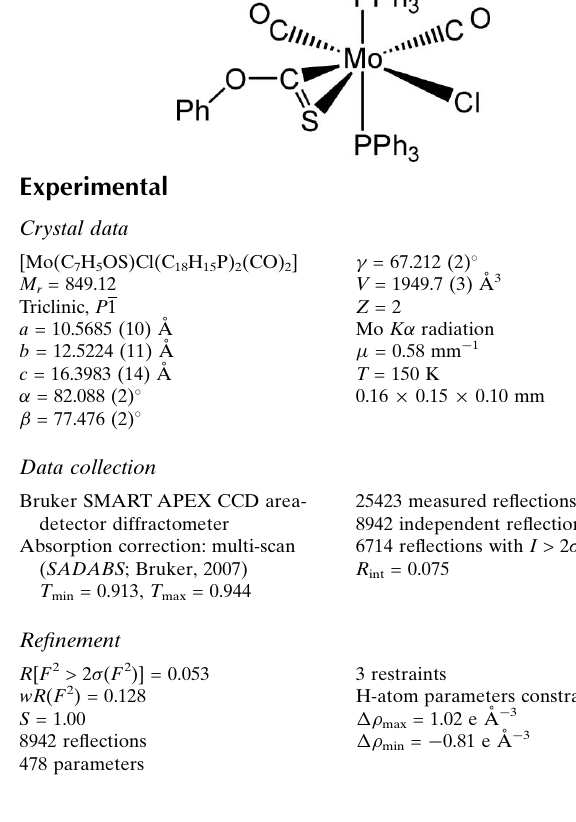
Hydrogen-bond geometry (A˚ , (cid:3)